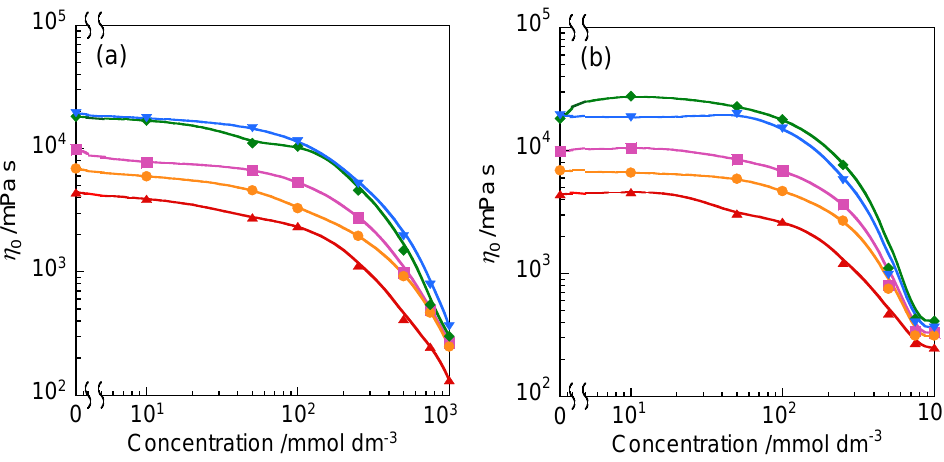
Figure 2. Surface tension as a function of the volume fraction of C 12 EO 6 in amphiphilic gemini ionic liquids at 25 °C: 2C 10 (2-O-2) NTf 2 (orange ●), 2C 12 (2-O-2) NTf 2 (pink ■ ), 2C 14 (2-O-2) NTf 2 (40 °C, red ▲ ), 2C 12 (2-N-2) NTf 2 (blue ▼ ), and 2C 12 (2/2-N-2) NTf 2 (30 °C, green ◆ ).